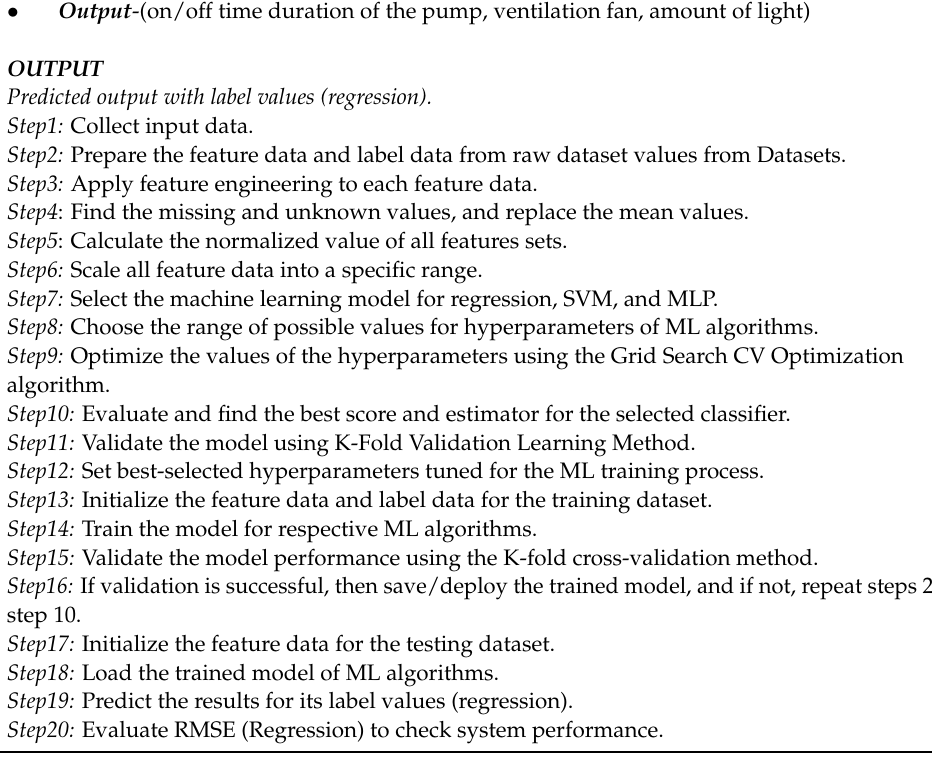
Algorithm 1. Proposed